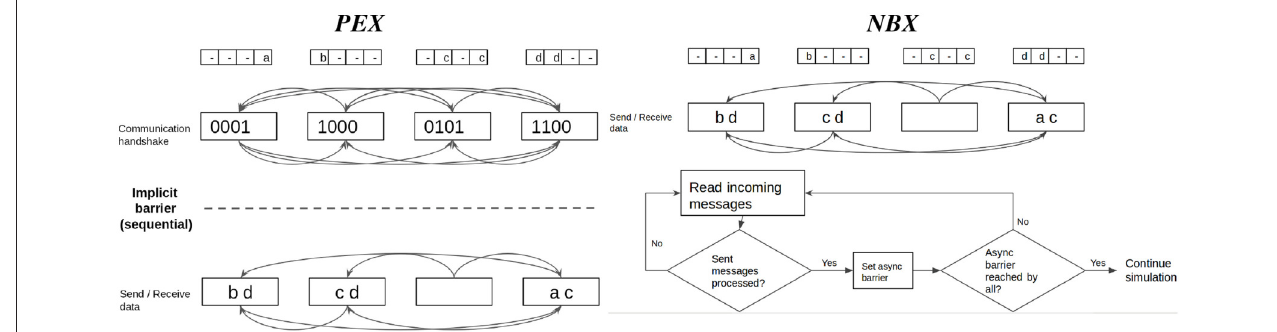
FIGURE 6 | Point-to-point communication strategies compared. Personalized Exchange ( PEX ) involves an explicit handshake to coordinate communication intention amongst processes before exchanging data. First, processes share metadata in an all to all manner; in a second round, processes send data only to those that need to receive spiking data. Neighbor Exchange ( NBX ) overlaps both phases with the use of asynchronous barrier, which allows processes to send and receive spiking data while waiting for notification that other processes have completed sending data, minimizing synchronization